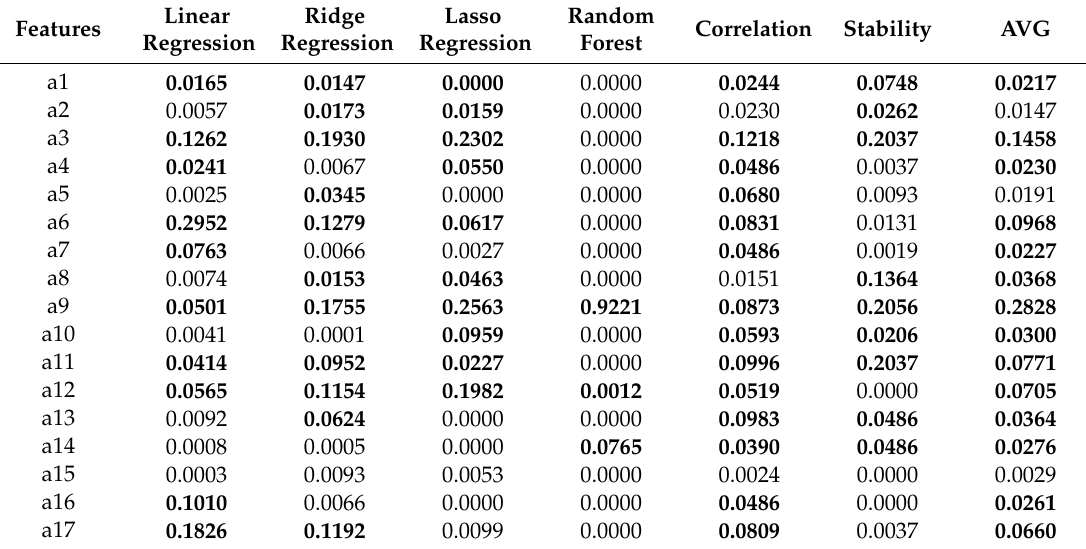
Table 2. Contribution of features by di ff erent selection methods for the H